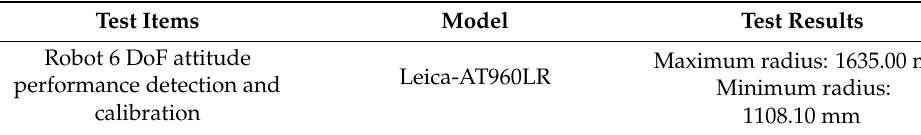
Table 4. Position repeatability.